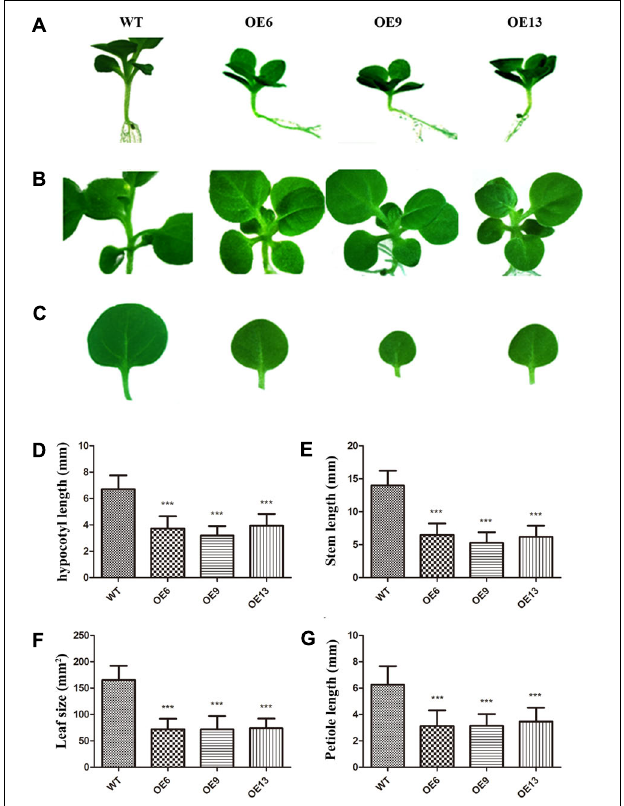
FIGURE 3 | Phenotypes of ZmDREB4.1 -overexpressing tobacco. Compared with WT, ZmDREB4.1- overexpressing tobacco exhibited shorter hypocotyls (A) , stems (B) and petioles and smaller leaves (C) . The tobacco plants at the two-leaf stage were chosen for hypocotyl observation, and tobacco plants at the four-leaf stage were chosen for observation of stem, petiole, and leaf. Scale bar: 5 mm. Column diagrams in (D–G) showed quantitative determination of hypocotyl length, plant height, petiole length and leaf size, respectively. For (D–G) , the values represent the mean ± SD from 25 separate plants of each of three independent transgenic lines and the statistically significant differences were evaluated by Student’s t -test and corrected by Bonferroni correction ( ∗∗∗ P -value <